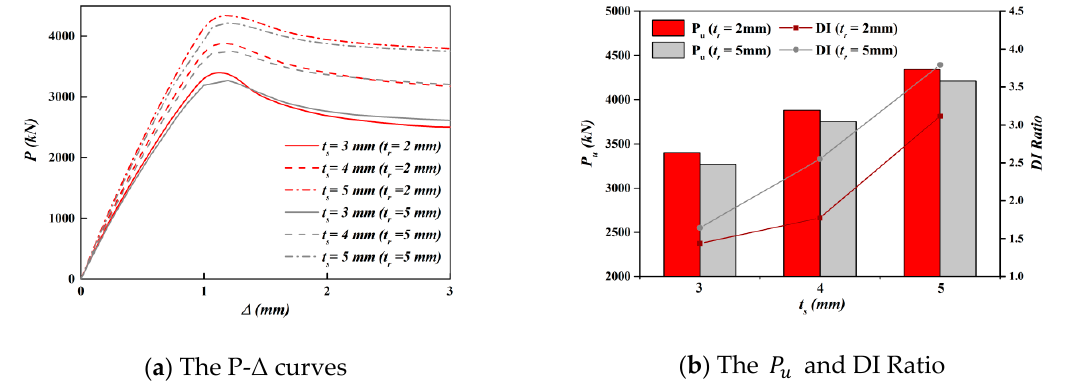
Figure 17. Influence of thickness of steel plates on compressive resistance of SDC wall.